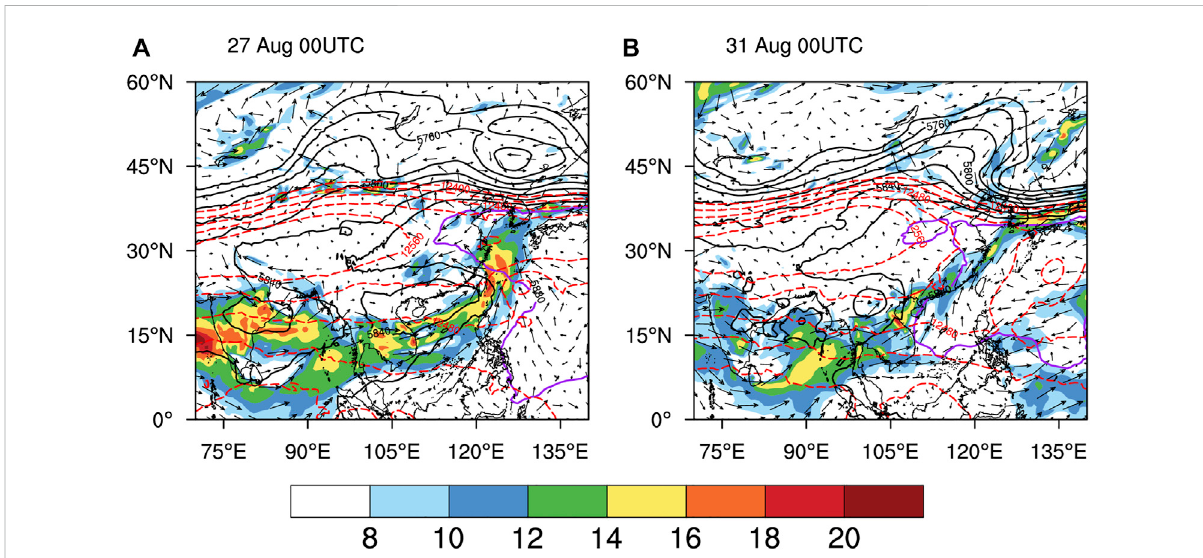
FIGURE 6 200 hPa geopotential height (red dashed line, unit: gpm), 500 hPa geopotential height (thick black solid line, purple line denotes 5,880 gpm contour, unit: gpm), and 850 hPa wind (vector, unit: m · s − 1 , wind speed greater than 8 m s − 1 is shaded) at (A) 00 UTC on 27 August 2018 and (B) 00 UTC on 31 August